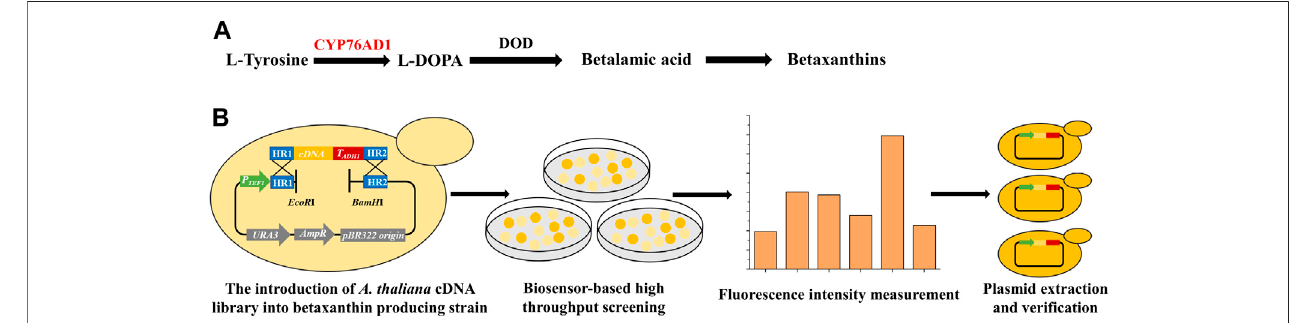
FIGURE 1 | Establishment of a high throughput screening method for identifying new target genes of the A. thaliana cDNA library to improve the functional expression of P450s. (A) The betaxanthin biosynthetic pathway starting from L-tyrosine, including a P450 enzyme (CYP76AD1, shown in red) and an L-DOPA dioxygenase (DOD). CYP76AD1 has been determined to be rate-limiting for betaxanthin production, indicating that the production of betaxanthin (yellow color or fl uorescence)canfunctionasabiosensorfortheexpressionlevelof CYP76AD1 . (B) Work fl owofthegenome-scaleengineeringexperiments.The A.thaliana cDNA overexpression library was introduced into the betaxanthin-producing yeast (yJS1256, biosensor strain) via in vivo homologous recombination. Clones with obvious color changes were selected and inoculated into SCD-URA medium in 96 deep-well plates and the fl uorescence intensities were measured using a microplate reader. Then the isolated plasmids were re-transformed into the biosensor strain and the corresponding genes were identi fi ed by DNA